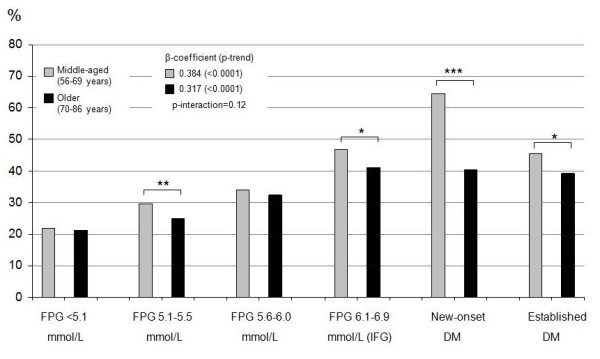
Proportion of men with three or more risk factors. The figure shows the proportion of men with three or more of the following risk factors: uncontrolled hypertension, dyslipidemia, central obesity, current smoker or being physically inactive; in each of the six glucometabolic status groups defined in the text. β-coefficients and p-values for trends from the 1st to the 5th groups are also shown. Brackets denote differences between age groups within each glucometabolic status group: * p < 0.05; ** p < 0.01; *** p < 0.001.